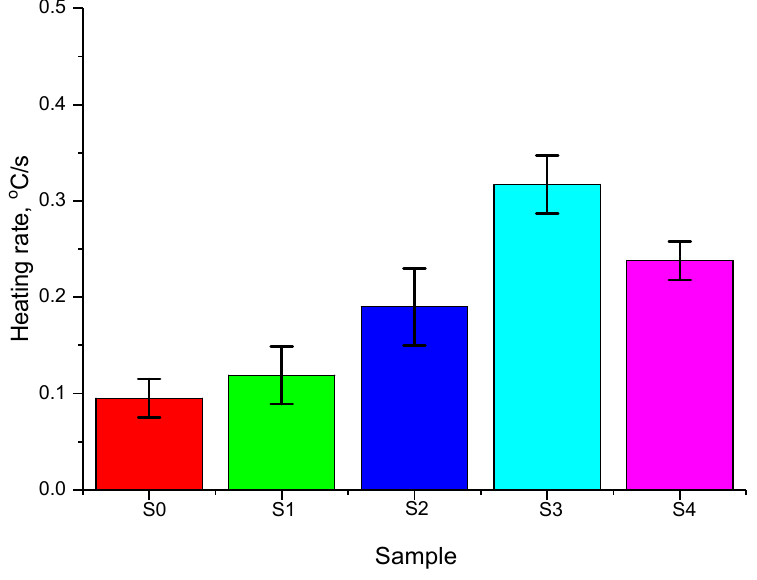
Figure 8. Diagram of the change in the heating rate of nanoparticles depending on their type.